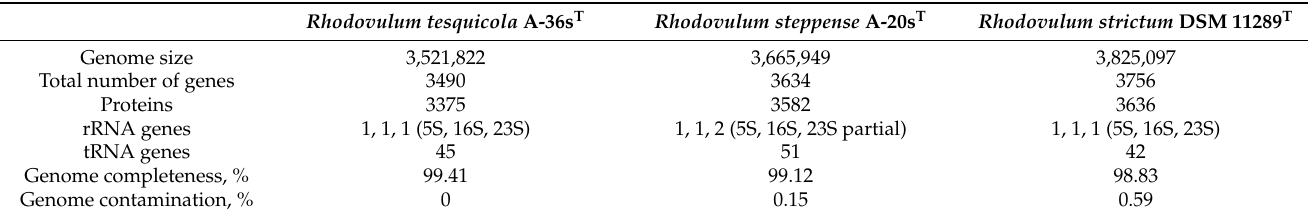
Table 1. Genome features of R. tesquicola , R. steppense and R. strictum , according to NCBI database. Rhodovulum tesquicola A-36s